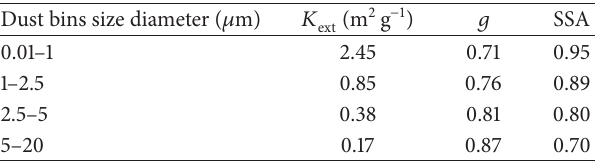
Table 1: Four dust bins and their optical properties in visible